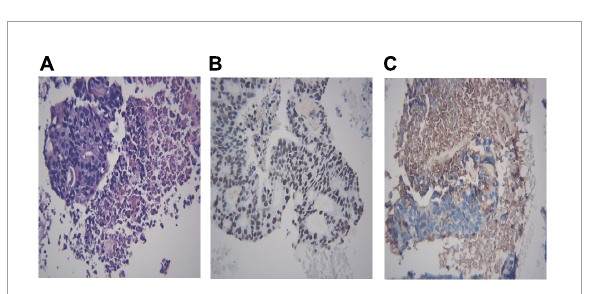
FIGURE8 Histological biopsy of a pulmonary adenocarcinoma with metastasis from gastrointestinal neoplasm. Tumor cells are grouped in clusters ( A , HE 400 × ) and positive for Brg-1 ( B , IHC 400 × ) and Claudin-4 ( C , IHC 400 × ). (A) Metastasis from gastrointestinal neoplasm, HE 400 × ; (B) Brg-1 400 × ; (C) Claudin-4 400 ×